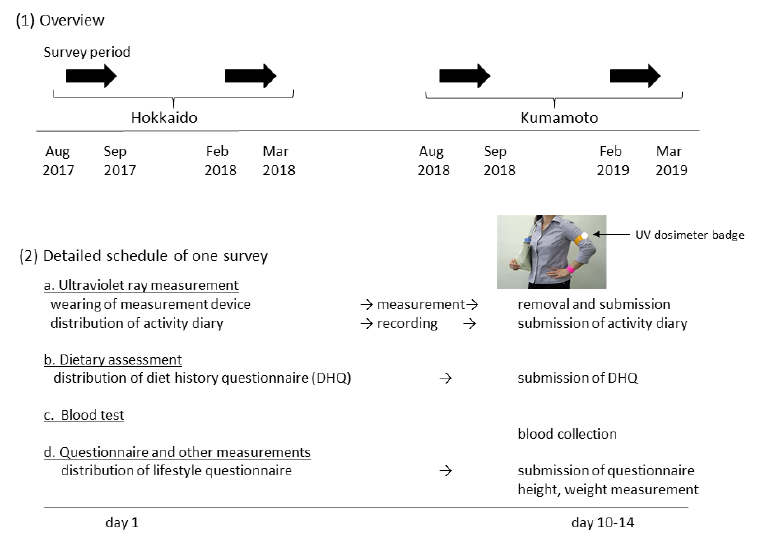
Figure 1. Survey schedule.